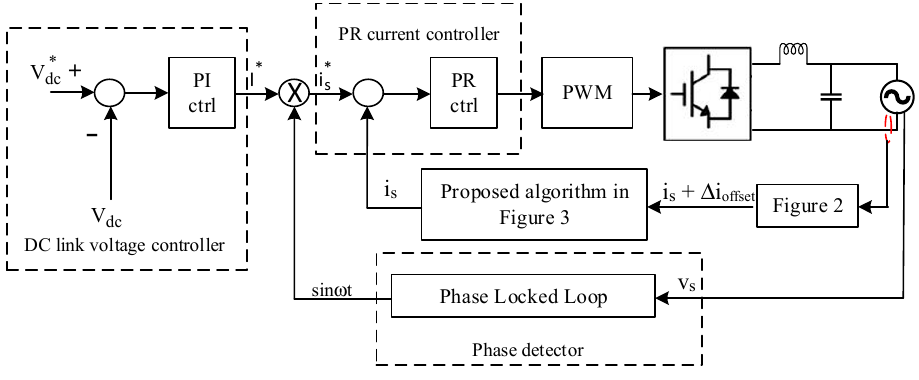
Figure 5. An entire system block diagram of the proposed DC offset error compensation algorithm developed for MATLAB/Simulink simulation.